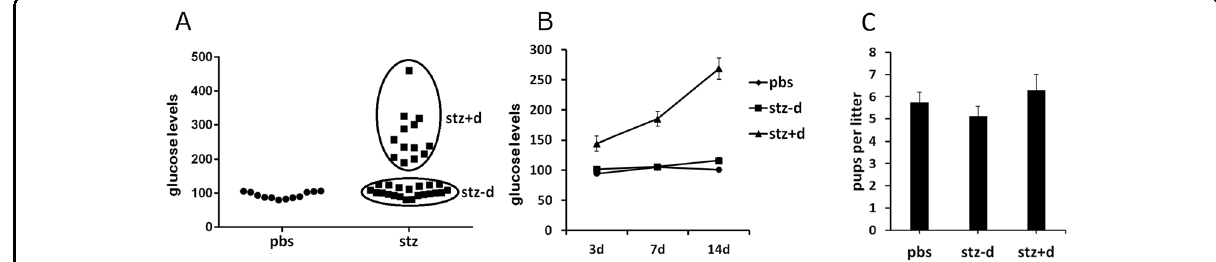
Fig. 1 STZ-induced gestational diabetes. A Blood Glucose levels at 2 weeks of pregnancy (14 days) in pregnant female mice that were injected with STZ at E0.5. STZ-treated mice either develop gestational diabetes by 2 weeks of age (STZ + D) or show very little increase in blood glucose levels (STZ − D), which are similar to pbs-streated mice. B Blood glucose level analysis of pregnant mothers at 3 days, 7 days, and 14 days post conception. Differences between STZ + D and STZ − D groups are already present at 3 days of pregnancy, but reach hyperglycemia only at 14 days of pregnancy. C Number of pups per litter in each experimental group. n = 8 litters per experimental group. Data are presented as mean ± standard error of the